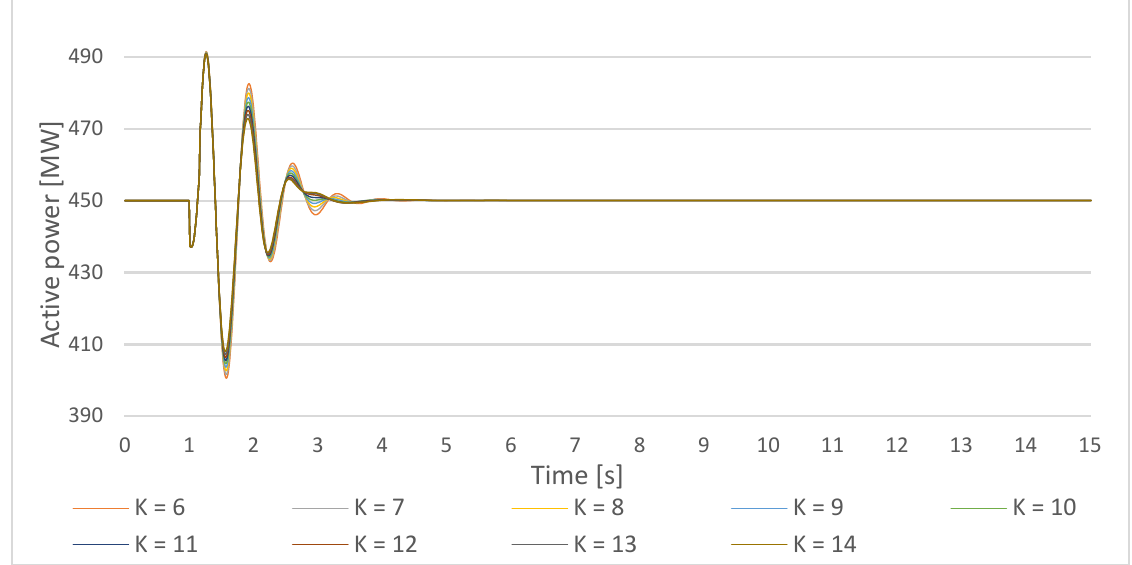
Figure 25. Gen1 active power response on a small disturbance with PSS parameters T = 0.5 s, the PSS gain increase in the lower cluster 1 - K i,ln = 6 – 10, and the upper cluster 1 K i,um = 10 – 14. Gen1 rotor angle settling time and the maximal undershoot increase with the increase of the PSS gain in both upper cluster 1 and lower cluster 1 in this study case. The active power and the generator speed undershoot decrease with the PSS gain increase while the settling times remain almost the same. Tables 9 and 10 give an overview of the proposed weight functions. Table 9. Weight functions for PSS parameters T = 0.5 s, K i,ln = 6–10, n = 1 ( lower cluster 1 ), t = 150 ms.